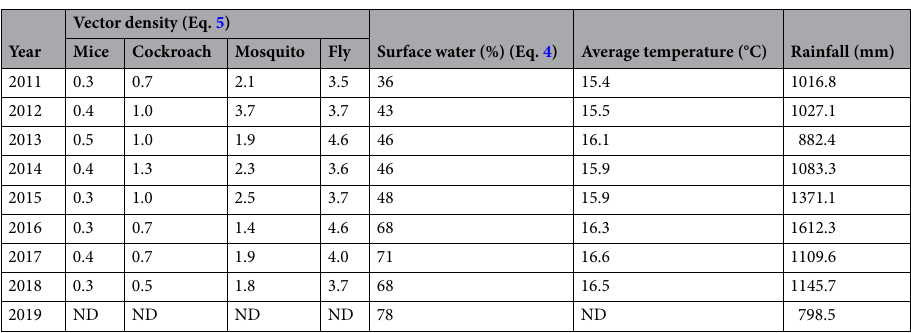
Table 2. Vector density, compliance rate of surface water quality, and average temperature in Jiangsu Province for each year during 2011–2019. ND no data available.